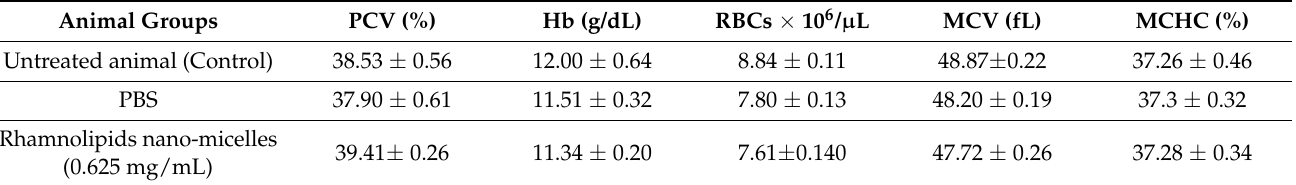
Table 5. * Effect of tested solutions, rhamnolipids nano-micelles and PBS (10 mM, pH 7.4) on the animal Erythrogram. Data are presented as an average ± SE, results are average of three